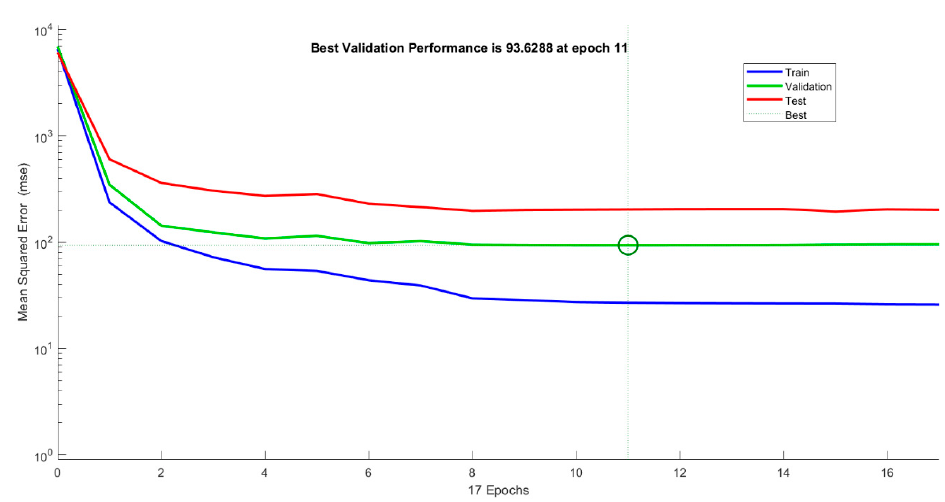
Figure 10. Leaning rate curve for ANN model performance with training, validation, and testing datasets in LPG plant.